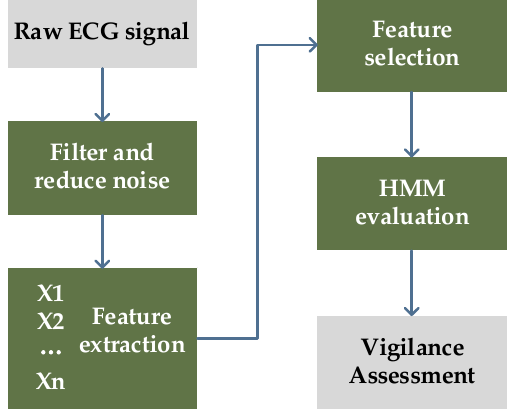
Figure 6. Modelling process of HMM for vigilance assessment.